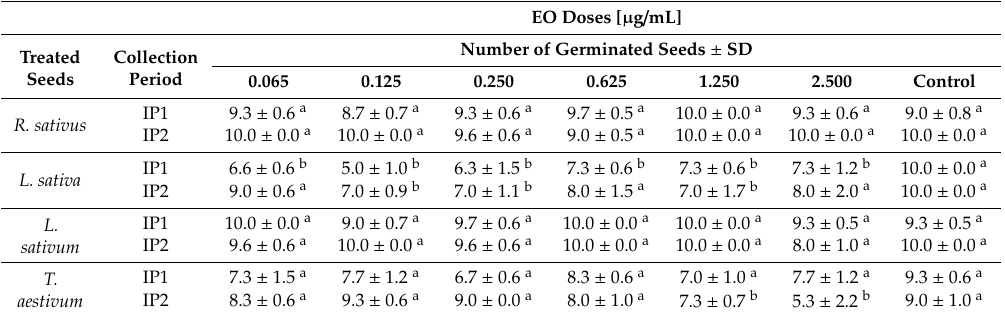
Table 3. E ff ect of di ff erent doses of EO from I. parviflora on the seed germination of three dicot and one monocot model plant species.